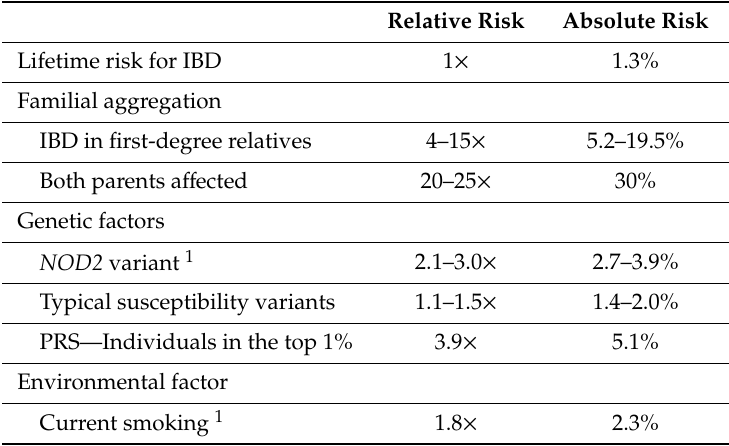
Table 1. Risk factors for inflammatory bowel disease